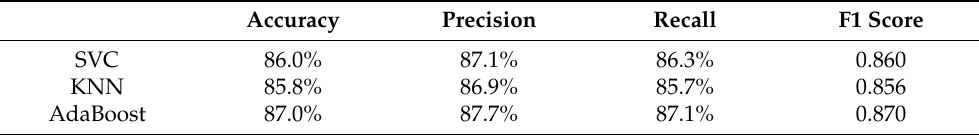
Table 20. Results for the classification models when trained using face and eye behaviour